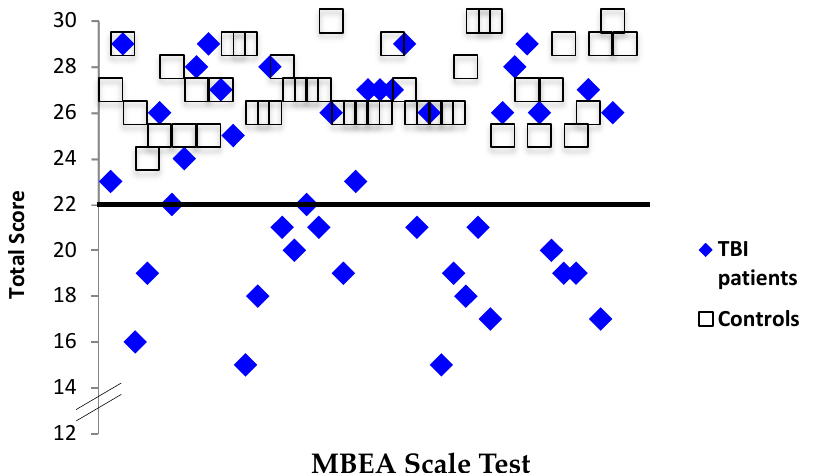
Figure 2. Individual scores for TBI patients and controls on the MBEA Scale test. Note. The black line represents the cutoff score for this test, which corresponds to two standard deviations below the mean (Peretz, 2003).